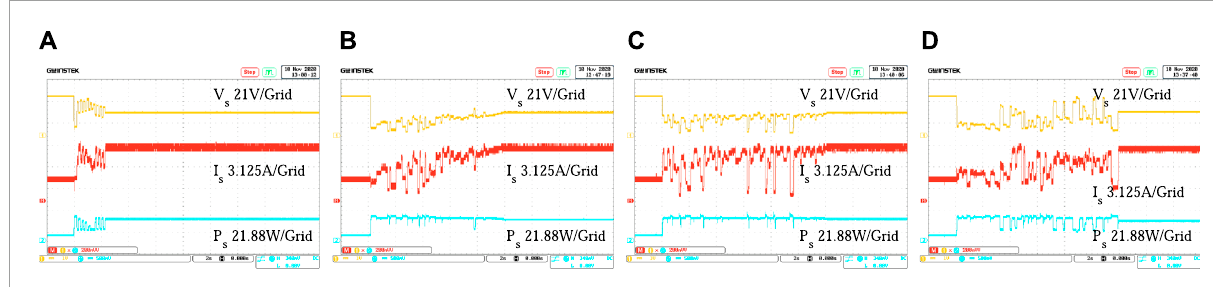
It shows the proposed algorithm consisting of three